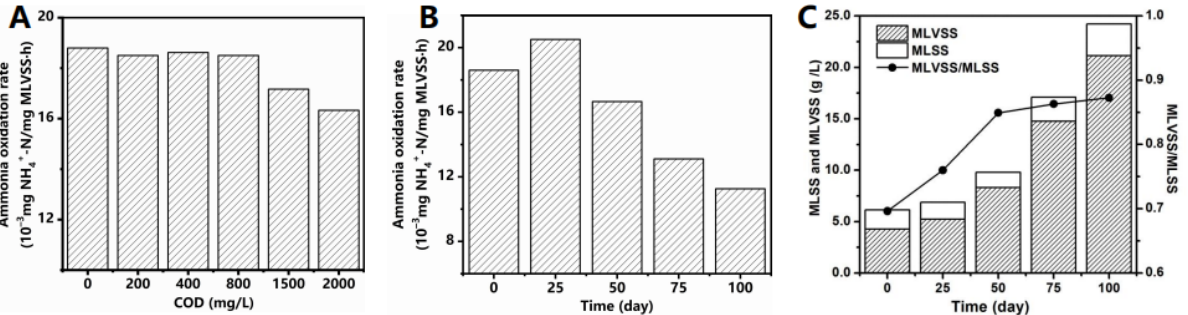
Figure 2. ( A ) Ammonia oxidation rate of seed sludge under different initial COD concentrations. ( B ) Ammonia oxidization rate of sludge at different stages. ( C ) Variation of the sludge concentration in the MBR.